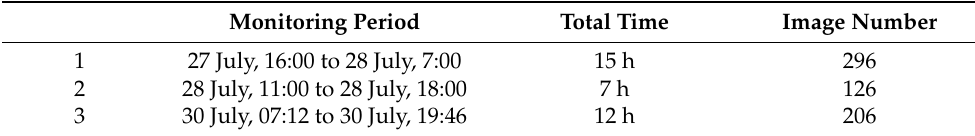
Table 2. Monitoring periods selected for analysis.